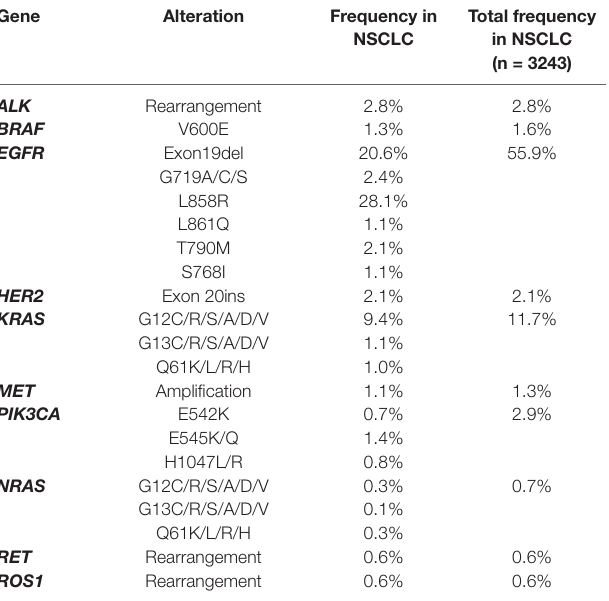
TaBLE 1 | Frequency of mutations in lung adenocarcinoma histologic subtypes.